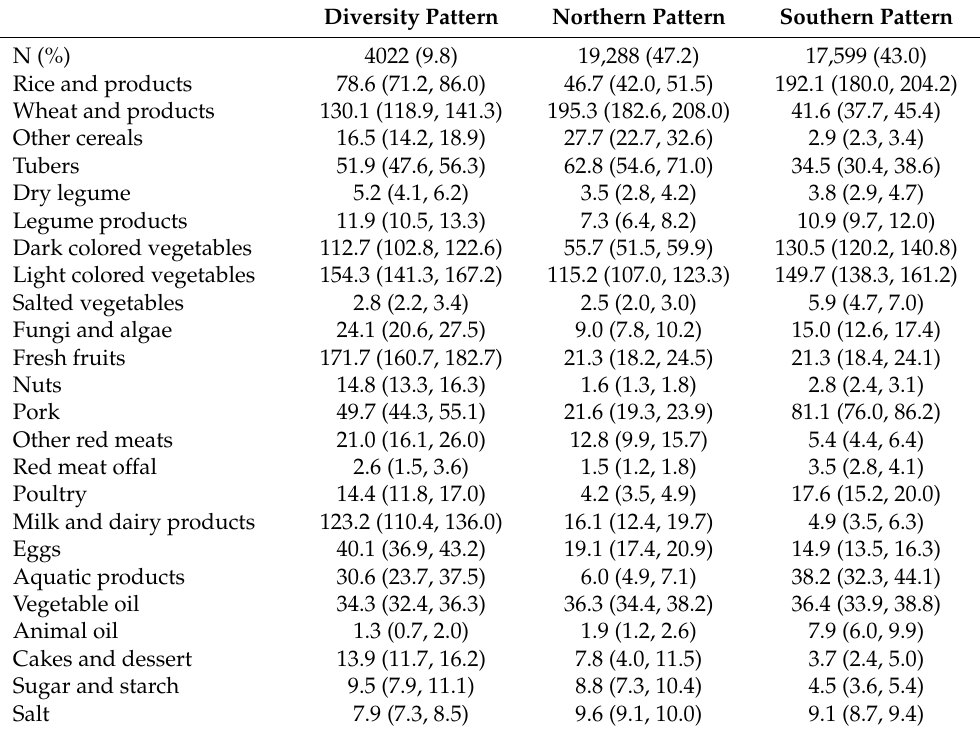
Table 3. Dietary intake among participants aged 45 y and above in three dietary patterns (mean, 95%CI,